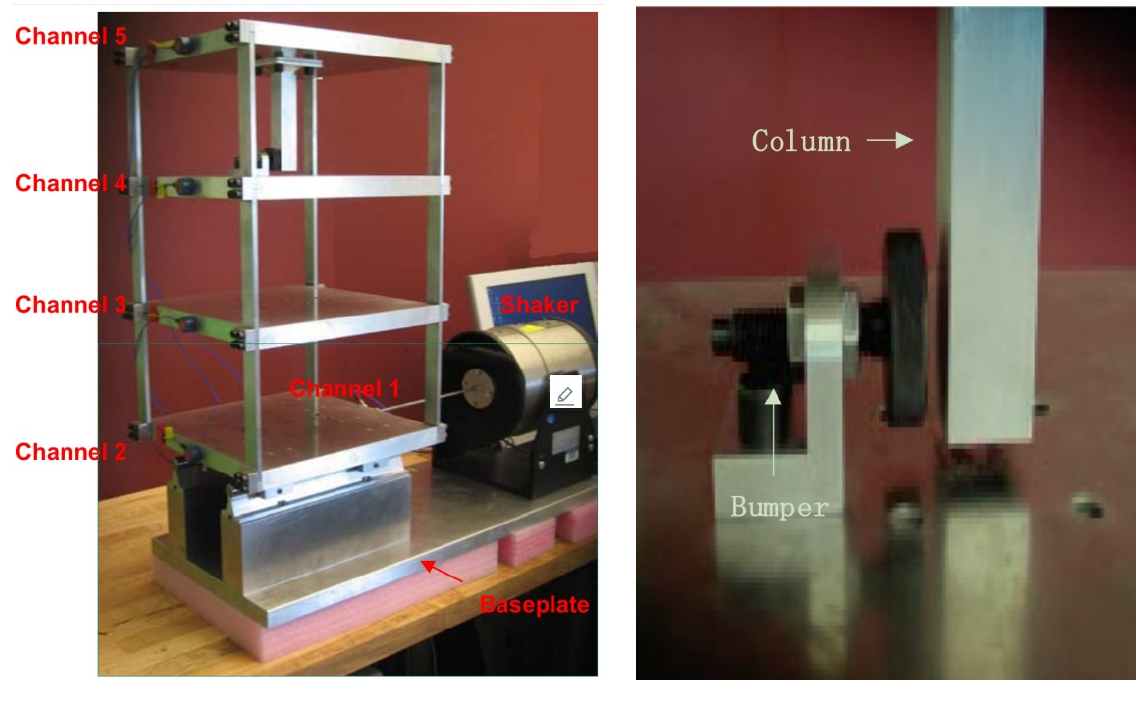
Figure 4. Experimental setup of the building structure.